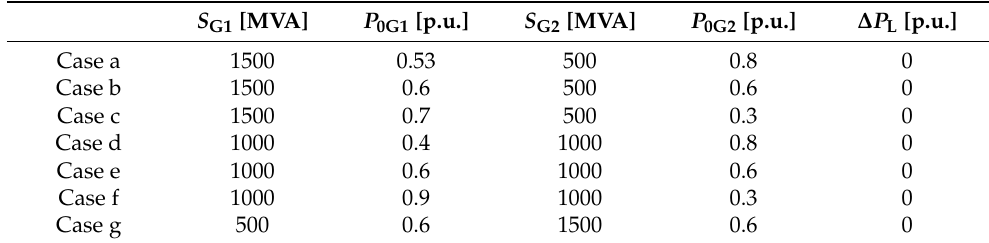
Table 5. Simulation parameters of the ramp changing solar irradiance fluctuation with the limiter control